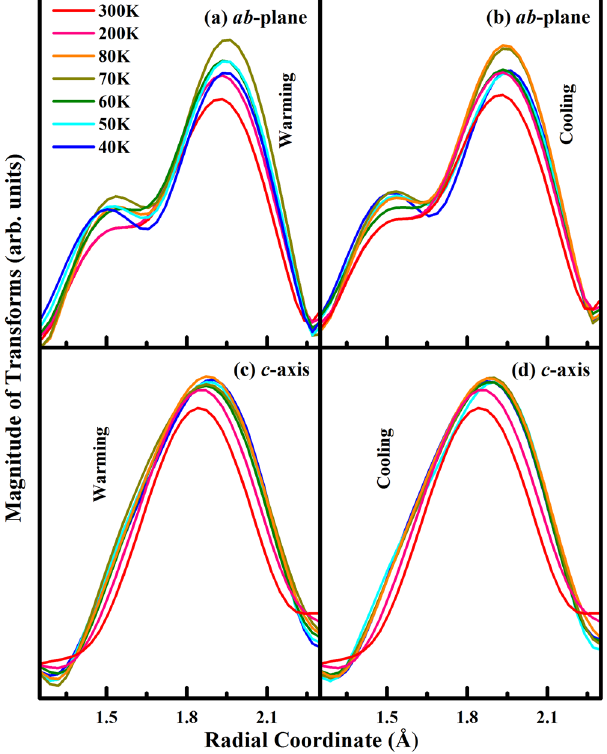
Figure 5. Temperature-dependence of the main FT feature A (corresponding to the NN Fe-O bond distance) of Fe K -edge EXAFS for ( a,b ) E // ab -plane and ( c,d ) E // c -axis in the warming and cooling